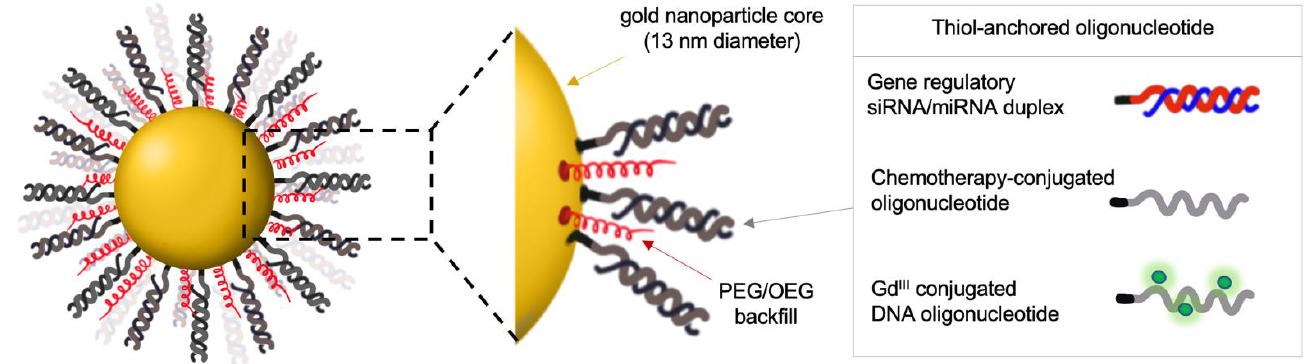
ticle templates, followed by the release of the siRNA oligonucleotide and its processing through the canonical RNAi pathway [35].